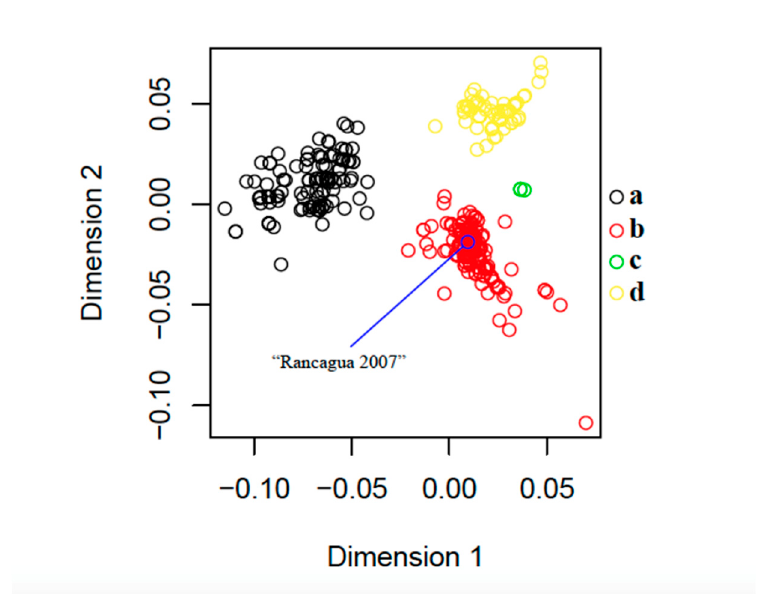
Figure 3. Classical multidimensional scaling (CMDS) based on 846 protein sequences of the PCV2 capsid gene (235 amino acid residues). The blue circle indicates the exact position of the sequence that was recovered in Rancagua in 2007. Following Franzo et al . (2015)[37], genotypes a ( n = 144), b ( n = 499), c ( n = 3), and d ( n = 200) are shown in black, red, green, and yellow, respectively (Supplementary Material, Table S1).